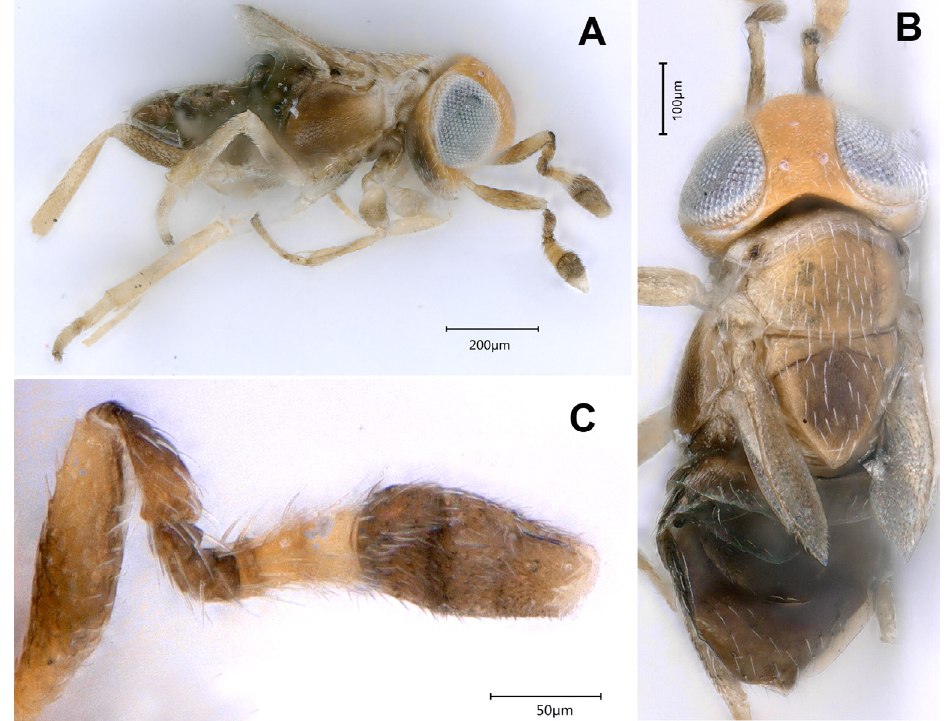
Fig. 5. Neococcidencyrtus poutiersi (Mercet, 1922), ♀. A . Lateral view. B . Dorsal view. C .